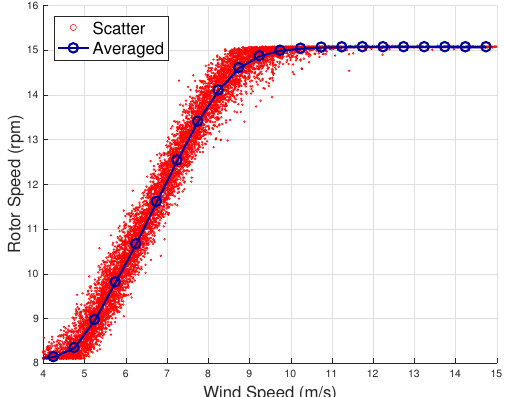
Figure 1. A sample scatter and binned wind speed—rotor speed curve for WF1.